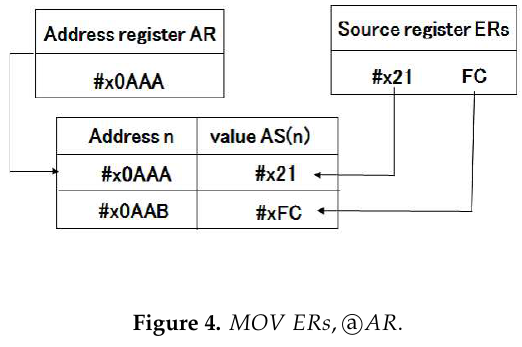
Figure 4. MOV ERs , a (cid:13) AR